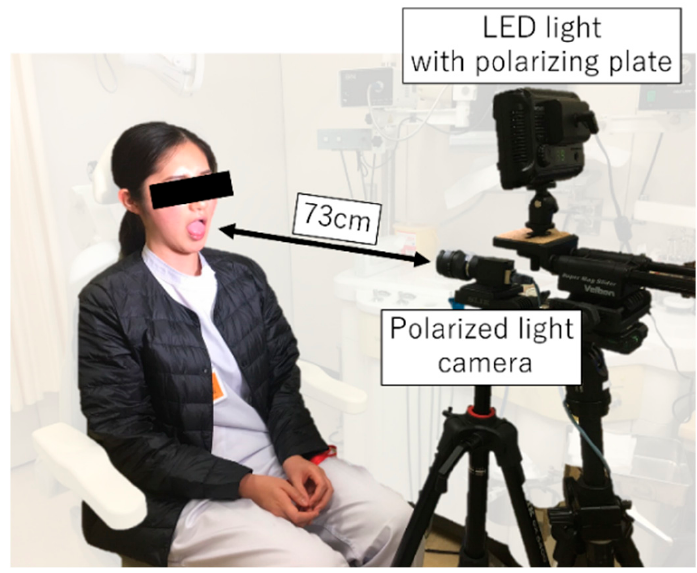
Figure 3. Experimental setup used to capture the tongue images.